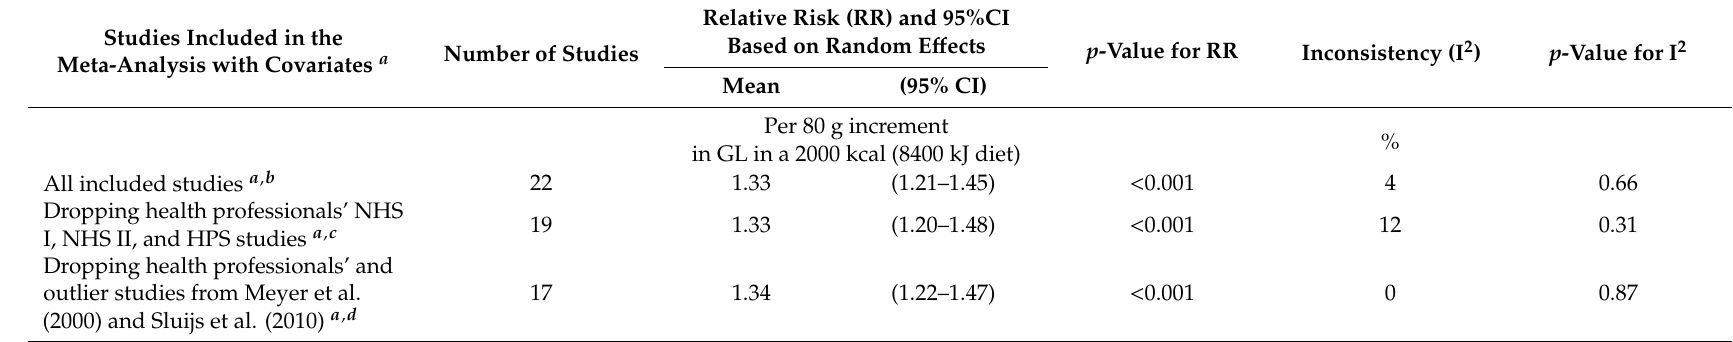
Table 6. The T2D–glycemic load risk relation with and without the three health professionals’ studies (NHS I, NHS II, and HPFS) in multi-covariate meta-analysis a . Studies Included in